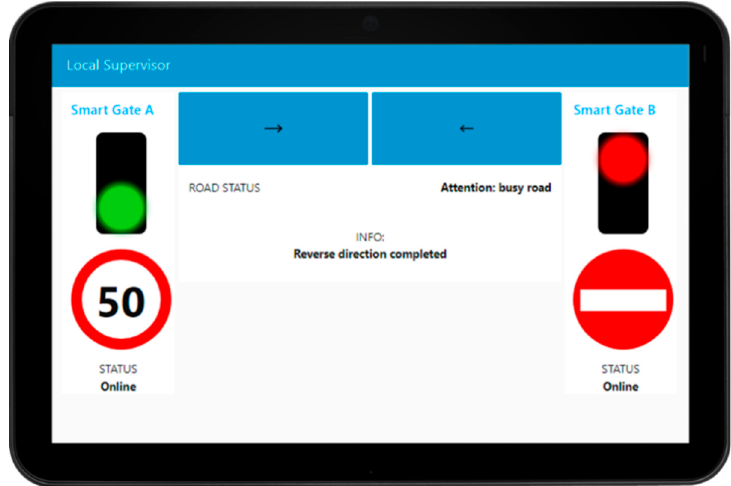
Figure 6. The interface (Dashboard) used to reverse the direction of travel on the road segment.